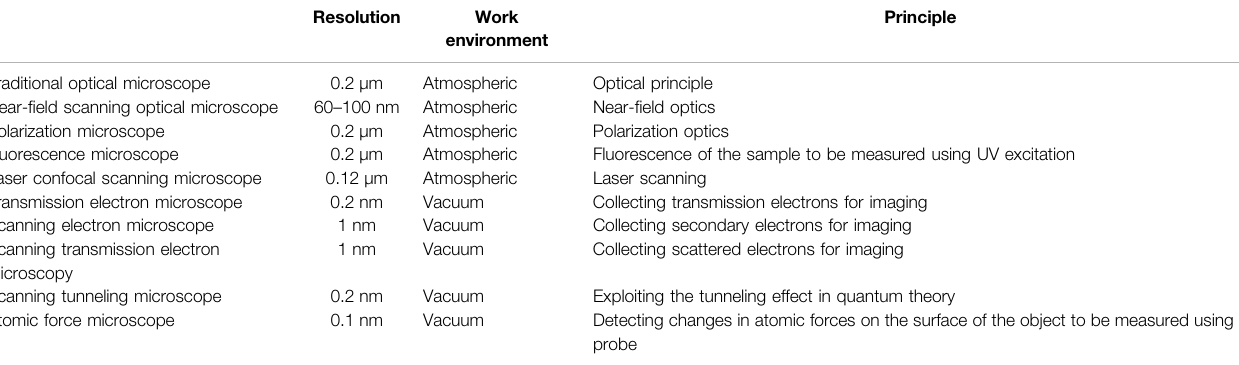
TABLE 1 | Summary of the characteristics of all the microscopes mentioned in the